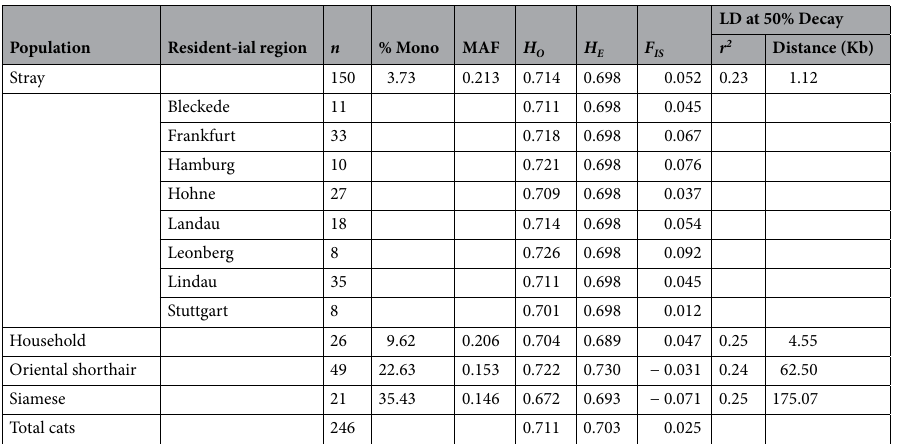
Table 1. Population summaries of percentage of monomorphic SNPs (% Mono), minor allele frequency (MAF), observed heterozygosity ( H O ), expected heterozygosity ( H E ), and fixation index ( F IS ), as well as linkage disequilibrium (LD) estimates of cat populations.